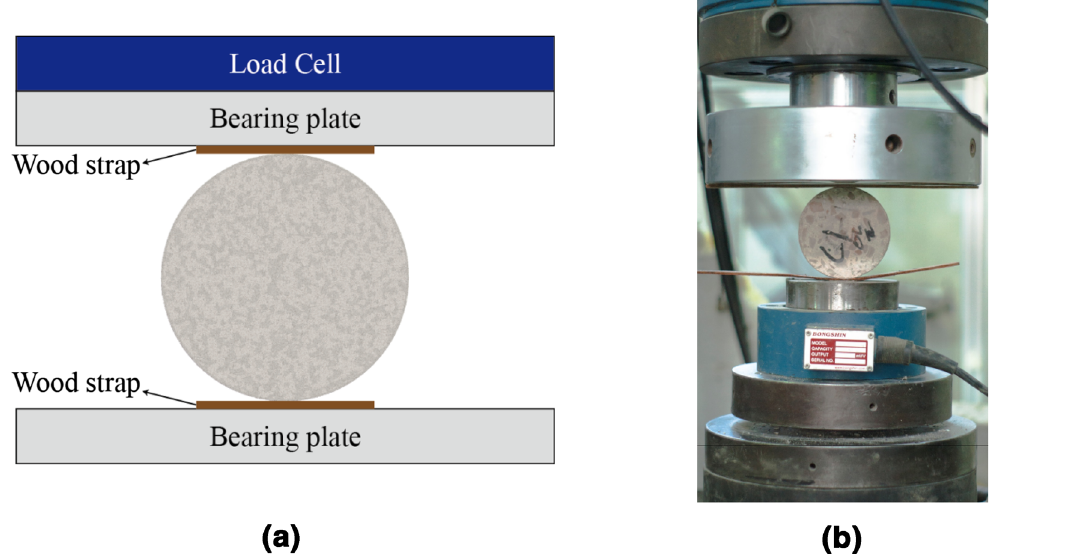
Fig. 5 Schematic diagram of splitting tensile strength test. a Schematic diagram and b experimental setup (Park et al. 2015).